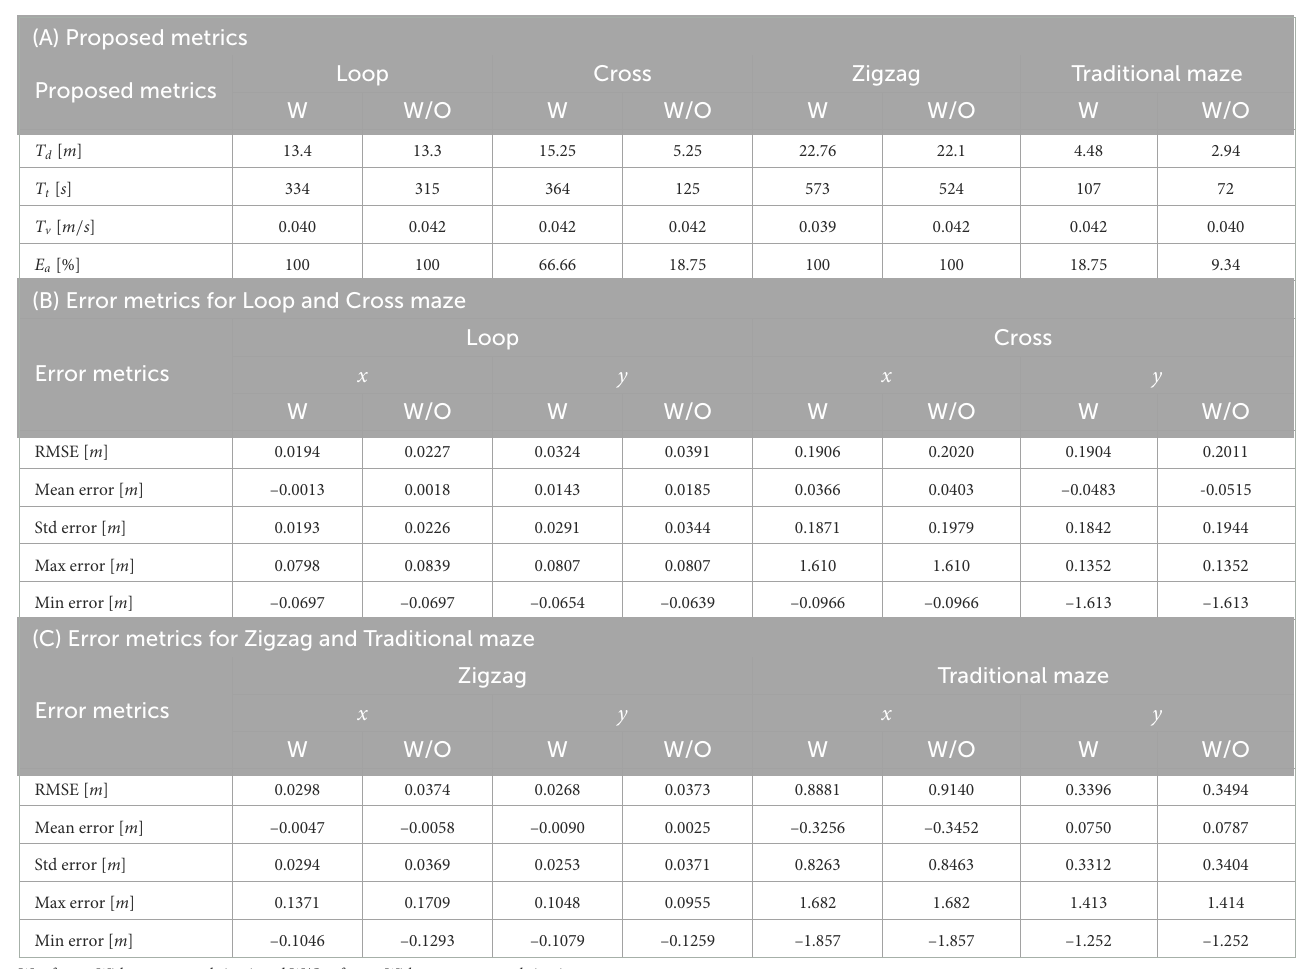
TABLE 2 Metrics values for simulation environments in Figure